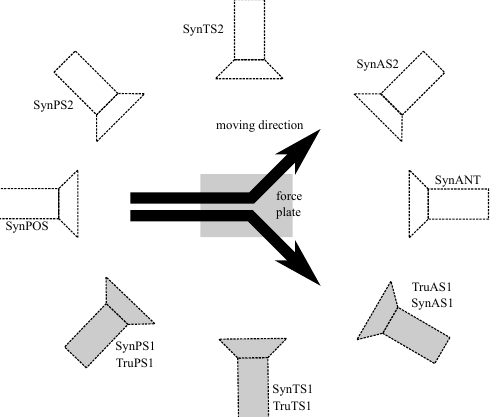
Figure 2. Set-up of the 2D video cameras during motion capture (grey), and eight additional synthe- sised camera views (white). During data collection, three in situ real cameras were positioned on the right side of the force platform in posterior-sagittal (TruPS1), true-sagittal (TruTS1), anterior-sagittal (TruAS1) positions with respect to the force plate and movement direction of the participant. The locations of the three in situ camera positions were also synthesised (SynPS1, SynTS1, SynAS1), along with an additional five synthesised camera views: posterior-sagittal (SynPS2), true-sagittal (SynTS2) and anterior-sagittal (SynAS2) on the left side of the force plate, with one positioned directly anterior (SynANT) and one posterior (SynPOS) to the force plate and the participant direction of travel. i.e. real cameras on the right side were synthesised on both the right and the left sides of the force plate. The 23 × 3D Vicon system cameras are not